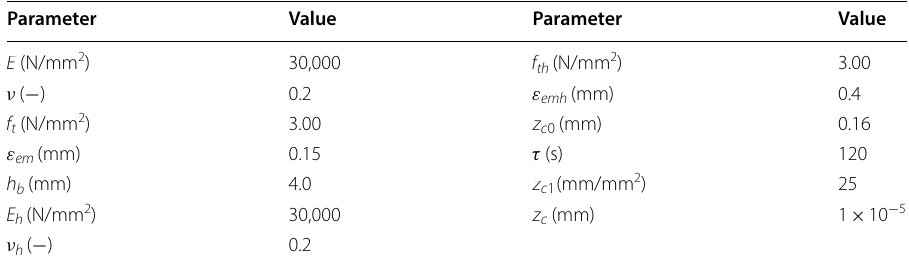
Table 1 Model parameters convergence test